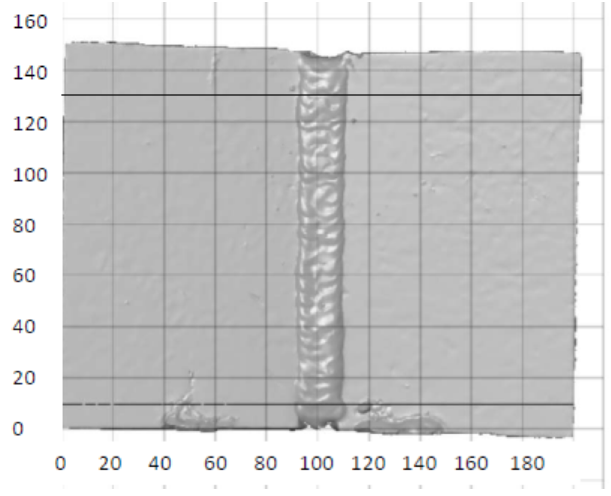
Figure 5. A3 sample shown in GOM